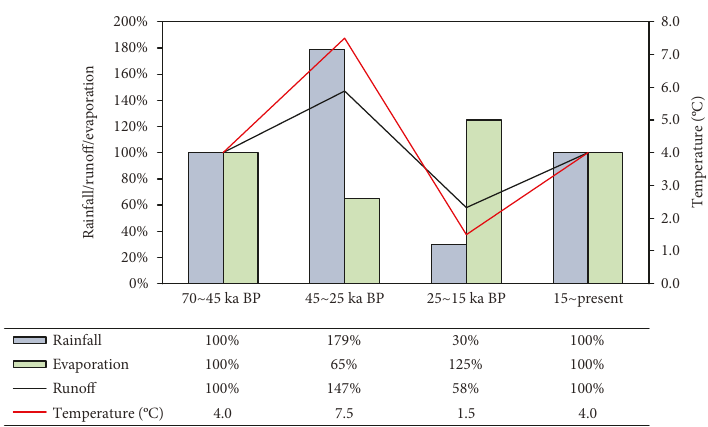
Figure 2: Paleohydrological characteristics of the Qaidam Basin since the last glacial period. Table 1: Hydrogeological parameters of di ff erent lithologies. Table 2: Chemical components used in the Lithology